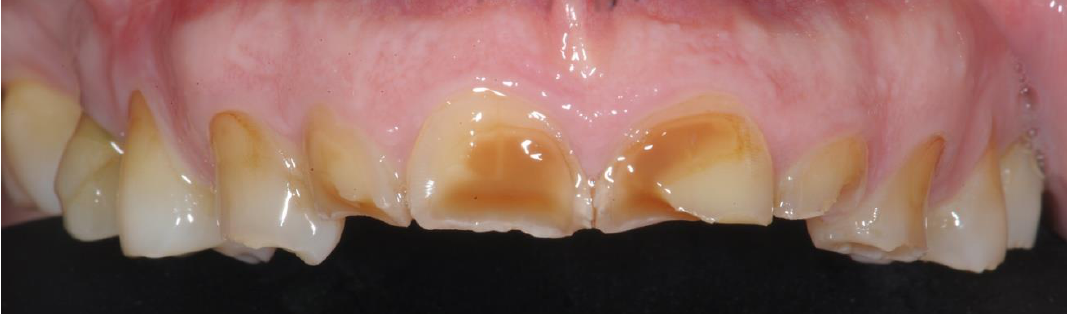
Figure 2. Case 1—Intraoral view of a patient with eating disorders and severe parafunctional habits.